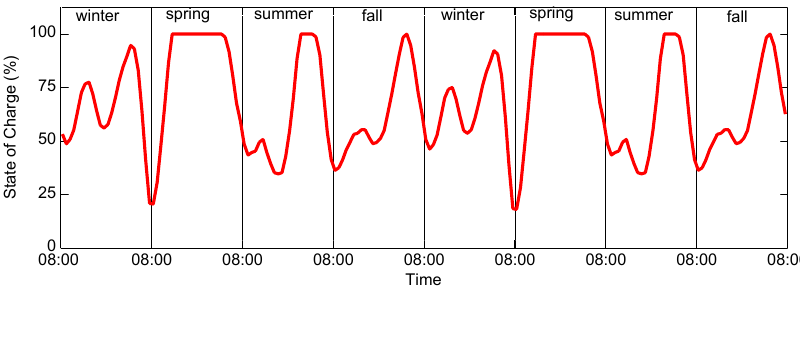
Figure 9. Battery SOC fluctuation considering seasonal